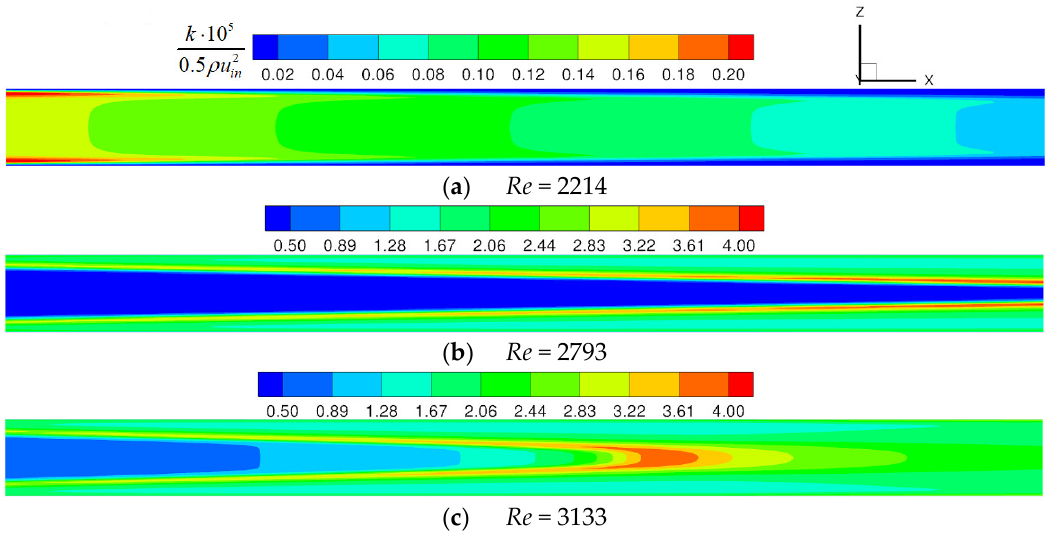
Figure 11. Dimensionless velocity magnitude contours on the middle cross section.